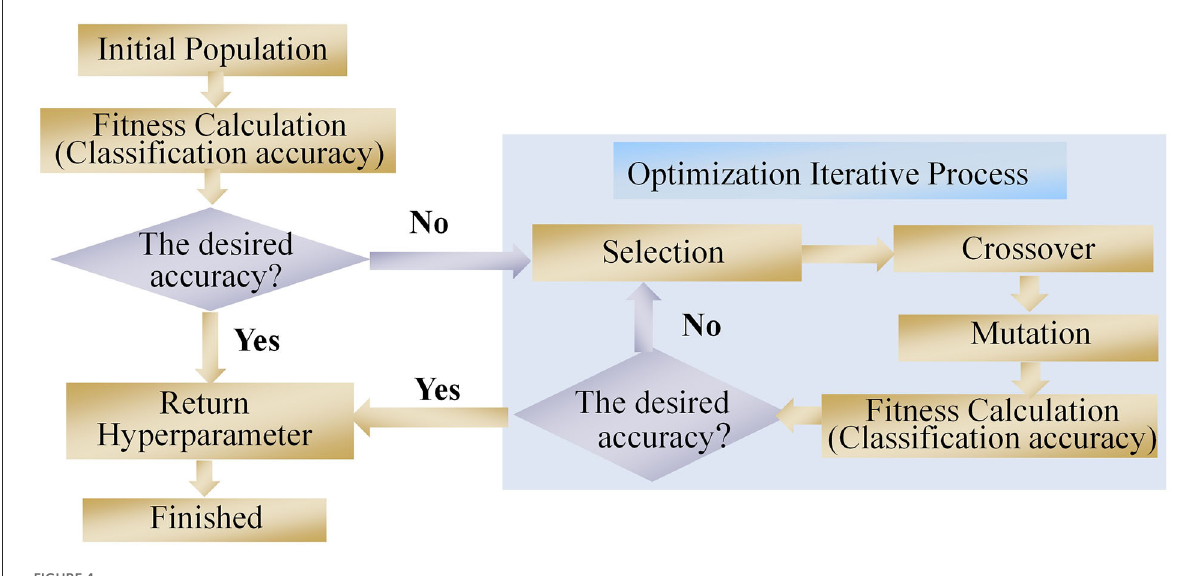
FIGURE4 Architecture of the proposed GA.